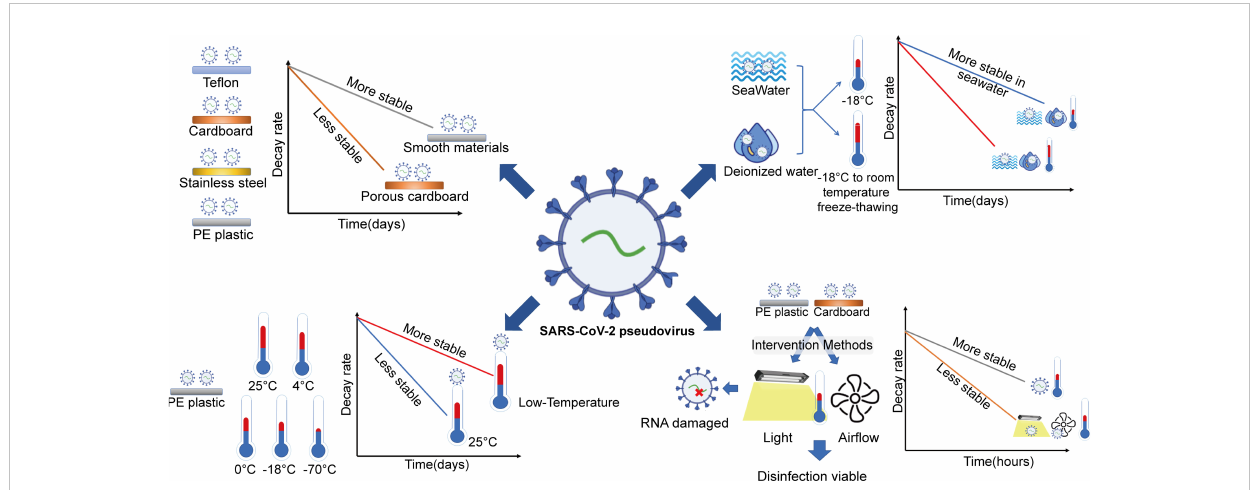
FIGURE 6 Stability of SARS-CoV-2 in cold-chain transportation environments and the ef fi cacy of disinfection measures. Cold-chain temperature and salt were risk factors that could prolong SARS-CoV-2 viability. Laboratory studies suggested that LED visible light exposure and air fl ow movement could promote the inactivation of SARS-CoV-2 in the cold-chain